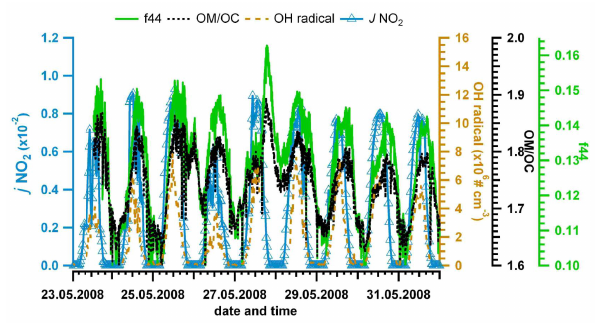
Fig. 4. Comparison of the f 44 and OM/OC time series with the OH radical concentration and NO 2 photolysis rate for the summer campaign.